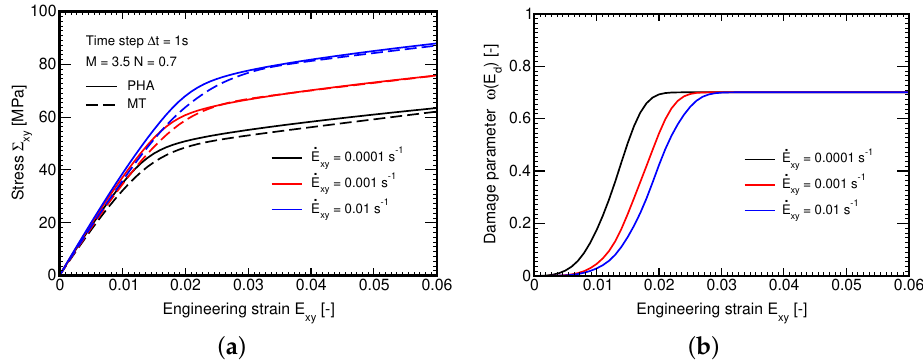
Figure 13. ( a ) Evolution of stress Σ xy for different strain rates with model parameters fitted to − 1 : comparison of MT and PHA predictions, ( b ) Evolution of damage parameter ω for ˙ E xy = 0.001 s different strain